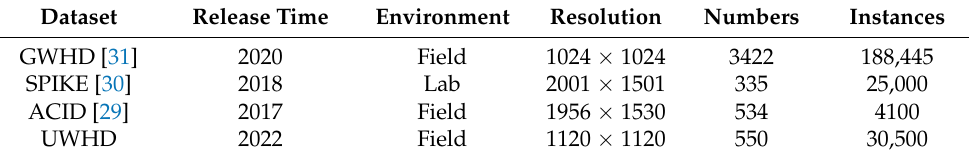
Table 1. Details of common wheat head datasets and our